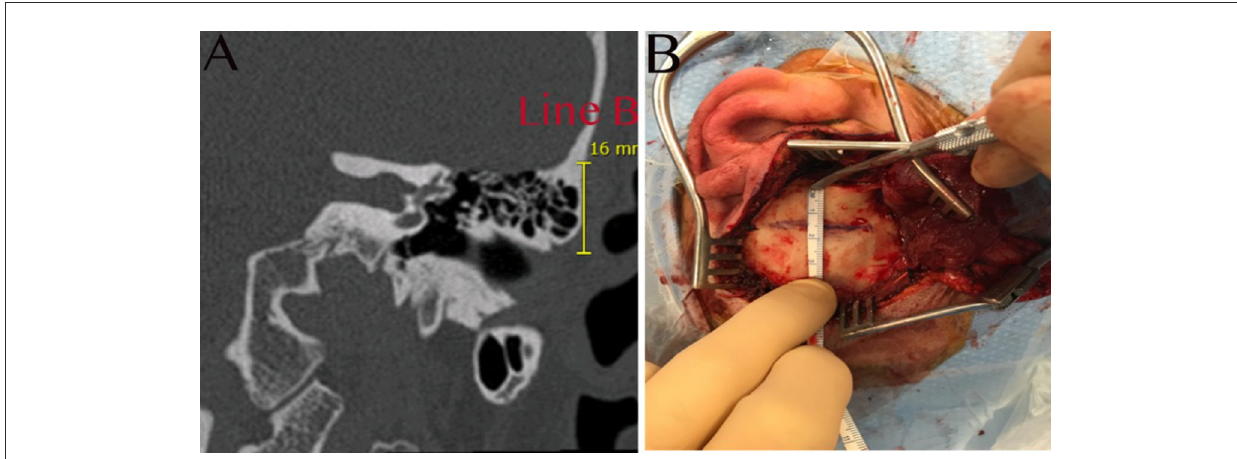
FIGURE2 (A) HRCT coronal view illustrating how the second measurement (line B) is taken vertically; this will represent the lower limit of the craniotomy to avoid opening the air cells, 16mm in this example. (B) The temporal bone is exposed, and the same measurement is demonstrated, taken from the superior part of the bony external auditory canal to the lower limit of the